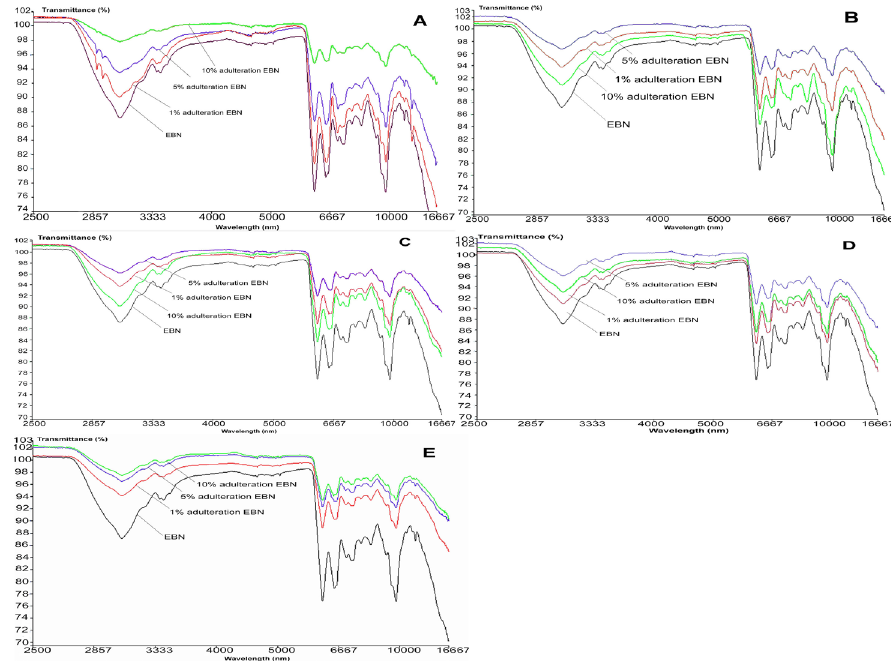
Figure 6. The MIR spectra of authentic EBN and adulterated EBNs at concentrations of 1, 5 and 10% (( A ) melamine, ( B ) karaya gum, ( C ) gelatine, ( D ) collagen, ( E ) nutrient agar). The similarities and differences between EBN and the adulterants in terms of chemical composition indicate that the ability to detect adulteration in EBN may differ for both VIS/SW-NIR and MIR techniques. Gelatine (VIS/SW-NIR) and melamine (MIR) show distinct differences in IR bands when compared to authentic EBN, hence the differentiation between them is expected to be easily performed. Overall, the visual inspection of both VIS/SW-NIR and MIR spectra indicates that there are marked differences between authentic EBN and the pure adulterants, but they are less obvious between authentic and adulterated EBNs. Hence, it is imperative to have the findings from both techniques further explored using chemometrics, starting with PCA and followed by multi-class discriminant analysis. 3.2. Adulteration Classification 3.2.1. PCA and OPLS-DA of Near-Infrared Spectrum In Figure 7, the principal component analysis was performed to observe the variation, trend or overlapping across the samples without class separation. The spectra pre-processing applied was the standard normal variate (SNV). There was a clear separation between the pure adulterants and the pure or adulterated EBNs. The samples outside the 95% confident interval circle were significantly different from those inside the circle. All of the adulterants plotted outside of the circle indicate that adulterants are different from EBNs in terms of the chemical composition. However, there are some authentic EBNs which fall outside of the circle. This observation could be due to the differences caused by geographical origin [36].